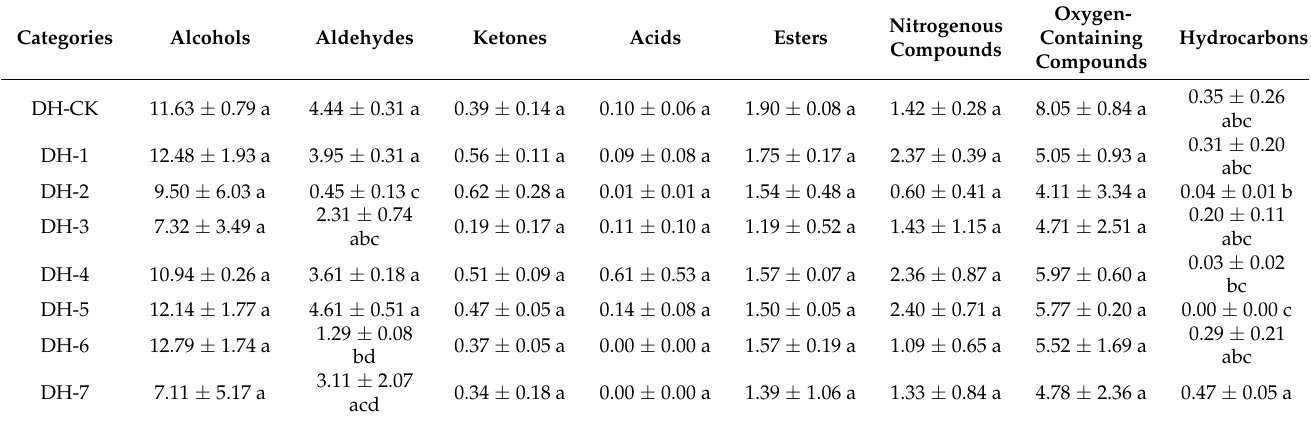
Table 1. Total relative contents of eight aroma compounds in aroma-enhanced Yunnan congou black tea baked at 90 ◦ C for 0–7 h (mean ± sd, n =